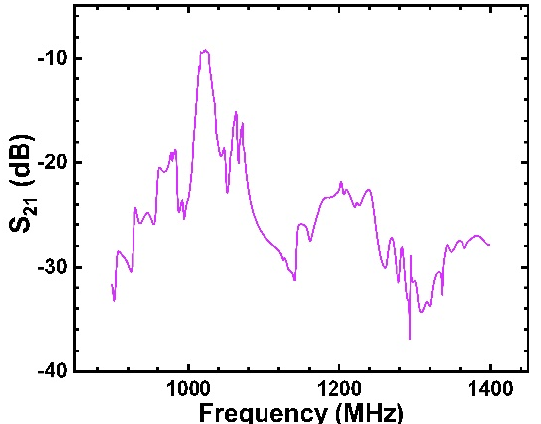
Figure 20. S 21 characteristics of SAW filter of SiO 2 /IDT/LiNbO 3 /diamond/Si structure with Rayleigh mode.